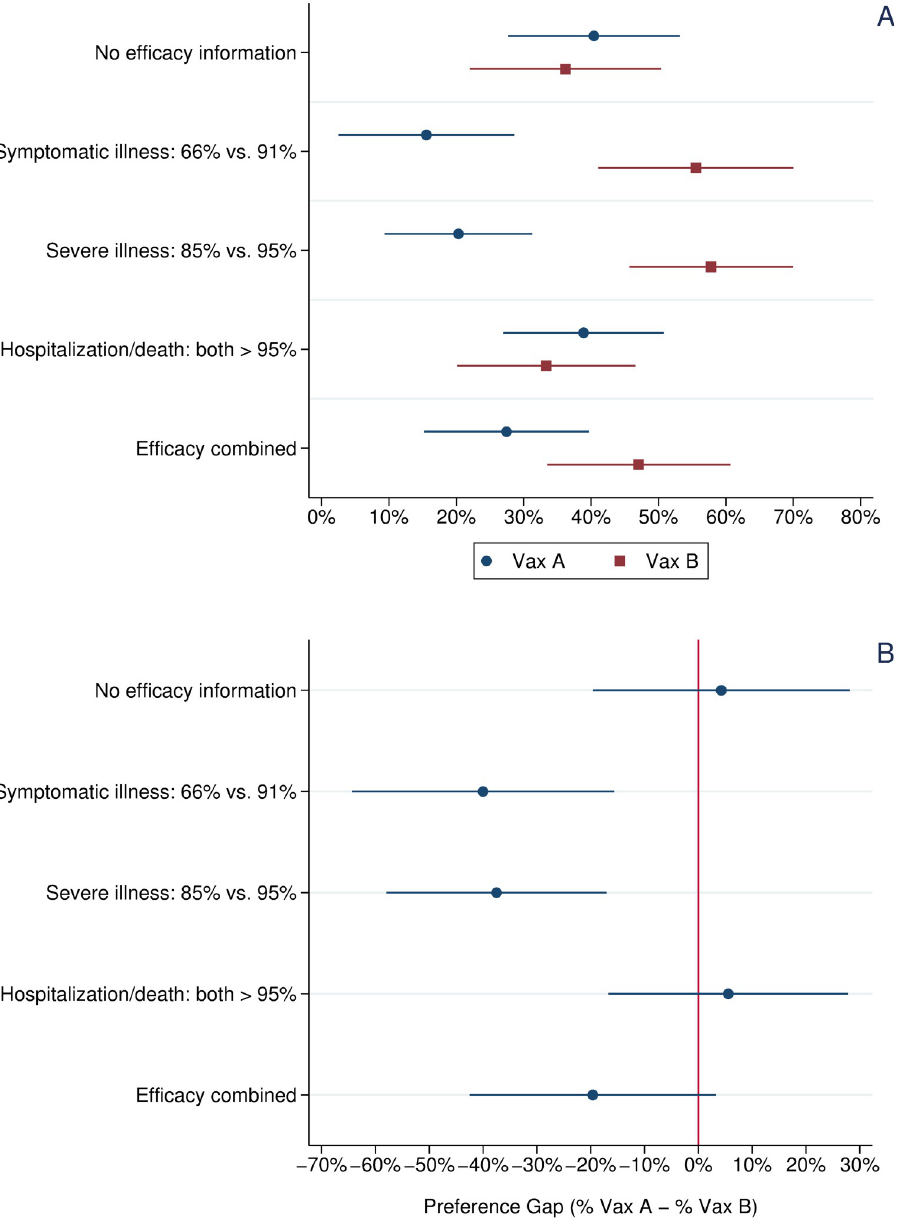
Fig 3. Vaccine choice and preference gap across experimental treatments, blacks and latinos. Note : Panel A: Circles indicate the percentage choosing Vaccine A, a one-shot, viral vector vaccine with efficacy data mirroring that reported in the Janssen vaccine trials. Squares indicate the percentage choosing Vaccine B, a two-shot, mRNA vaccine with efficacy data mirroring that reported in the Pfizer vaccine trials. Panel B: Circles indicate the preference gap between Vaccine A and Vaccine B. Horizontal bars present 95% confidence intervals about each mean